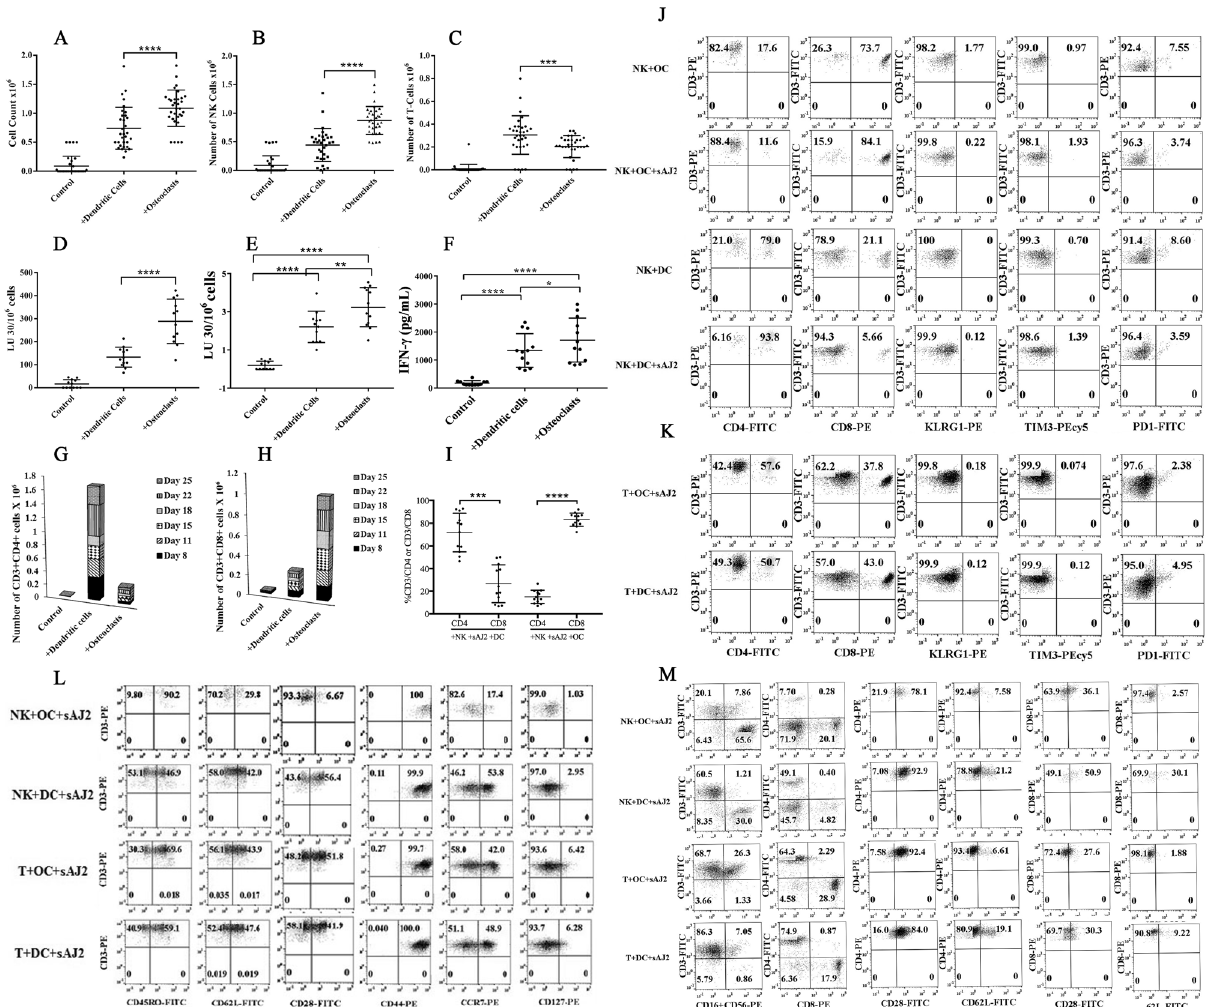
Figure 4. OC-expanded NK cells induced CD8 + T cell expansion whereas DC-expanded NK cells promote CD4 + T cell expansion. OCs and DCs were generated as described in Materials and Methods. NK cells from healthy individuals (1 × 10 6 cells/ml) were treated with a combination of IL-2 (1000 U/ml) and anti-CD16mAb (3 µg/ml) for 18 h before they were co-cultured with autologous DCs or OCs in the presence of sAJ2 at 1:2:4 ratios (DCs or OCs:NK:sAJ2). The expanding cells were counted on days 8, 11, 15, and 18 using microscopy (n = 30) (A). NK cells were co-cultured with OCs or DCs as described in Fig. 4A, and the surface expressions of CD3, CD16, and CD56 were analyzed on days 8, 11, 15, and 18 using flow cytometry. The numbers of NK cells and T cells were determined using the percentages of CD16 + and CD3 + cells, respectively, within the total cells in Fig. 4A (n = 30) (B, C) . NK cells were co-cultured with OCs or DCs as described in Fig. 4A and cytotoxicity of day 15 expanded cells was determined using a standard 4-h 51 Cr release assay against OSCSCs. LU 30/10 6 cells were determined using the method described in Fig. 1B (n = 12) (D) . NK cells were co-cultured with OCs or DCs as described in Fig. 4A, and the surface expressions of CD16 were analyzed on day 15 using flow cytometry. The levels of the cytotoxicity was determined based on 1% of CD16 + NK cells (n = 12) (E) . NK cells were co-cultured with OCs or DCs as described in Fig. 4A; the supernatants were harvested on days 8, 11, 15, and 18 of the co-cultures, and the amounts of IFN-γ secretion were determined using single ELISA (n = 12) (F) . NK cells were co-cultured with OCs or DCs as described in Fig. 4A. On days 8, 11, 15, 18, 22 and 25 of the co-cultures the surface expressions of CD3 + CD4 + and CD3 + CD8 + T cells were determined using flow cytometry, and the percentages were used to determine the total numbers of CD3 + CD4 + and CD3 + CD8 + cells within the total cells (n = 12) (G, H) . NK cells were co-cultured with OCs or DCs as described in Fig. 4A, and the surface expressions of CD3, CD4, and CD8 were analyzed on days 8, 11, 15, and 18 using flow cytometry. Percentages of CD4 + and CD8 + T cells within the CD3 + populations are shown in this figure (n = 12) (I) . NK cells were co-cultured with OCs or DCs as described in Fig. 4A and the surface expressions of CD4, CD8, KLRG1, TIM3, and PD-1 were analyzed within CD3 + cells on day 27 of the co-cultures using flow cytometry (n = 8) (J). T cells (1 × 10 6 cells/ml) from healthy individuals were treated with a combination of IL-2 (100 U/ml) and anti-CD3 (1 µg/ml)/CD28mAb (3 µg/ml) for 18 h before they were co-cultured with autologous DCs or OCs in the presence of sAJ2 at 1:2:4 ratios (DCs or OCs:T:sAJ2). Surface expressions of CD4, CD8, KLRG1, TIM3, and PD-1 were analyzed within CD3 + cells on day 27 of the co-culture using flow cytometry (n = 8) (K) . NK and T cells were co-cultured with OCs or DCs as described in Fig. 4A and Fig. 4 K, respectively. Surface expressions of CD45RO, CD62L, CD28, CD44, CCR7, and CD127 were analyzed within CD3 + cells on day 12 of the co-culture using flow cytometry (n = 8) (L) . NK and T cells were co-cultured with OCs or DCs as described in Fig. 4A and Fig. 4 K, respectively and the surface expressions of CD3, CD16, CD56, CD4, CD8, CD28, and CD62L were analyzed on day 12 of the co-culture using flow cytometry (n = 8) (M)